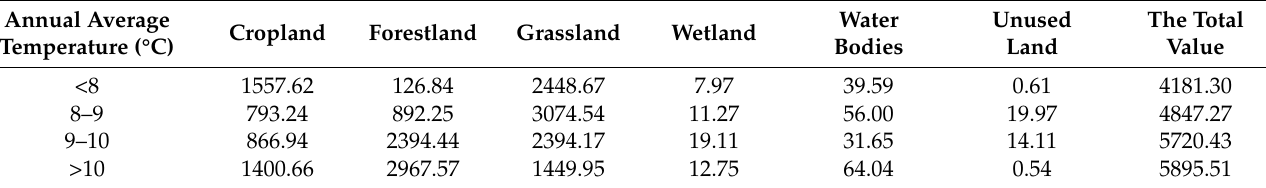
Table 6. ESV per unit area of different temperature levels. Unit: CNY/hm 2 .